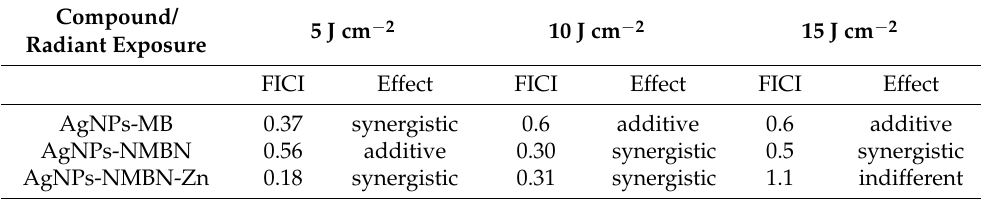
Table 4. Fractional inhibitory concentration index (FICI) of AgNPs-PS in F. keratoplasticum .